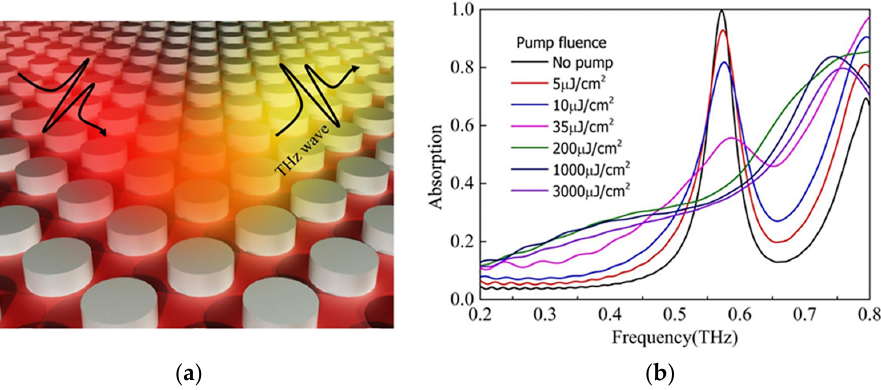
Figure 22. ( a ) Scanning electron microscope image of the all-silicon; ( b ) OPTP spectrum of the all-dielectric MPA for different pump fluences [59].